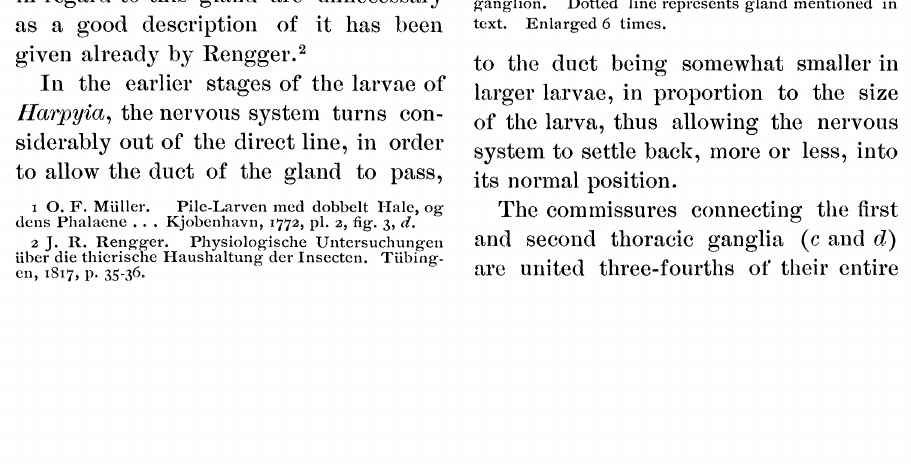
Fig. 5.--Vicw of anterior portion of central system of larva of arp/a v/nula from above a supraocsophageal ganglion;’ b infraoesophageal ganglion c, d and e, thoracic ganglia;f first abdominal ganglion. Dotted line reprcsents gland mentioned in text. Enlarged 6